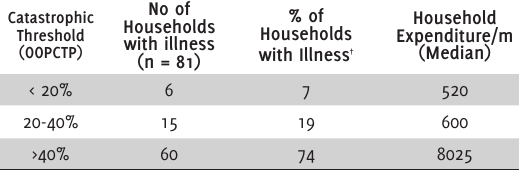
Table 3. Prevalence of Catastrophic Expenditure by Cut off Levels (of OOPCTP)